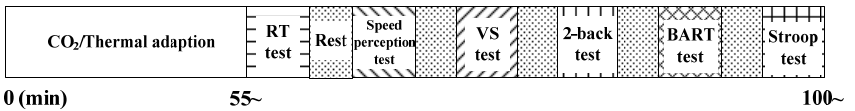
Figure 2. Experimental procedure of the cognitive tests.